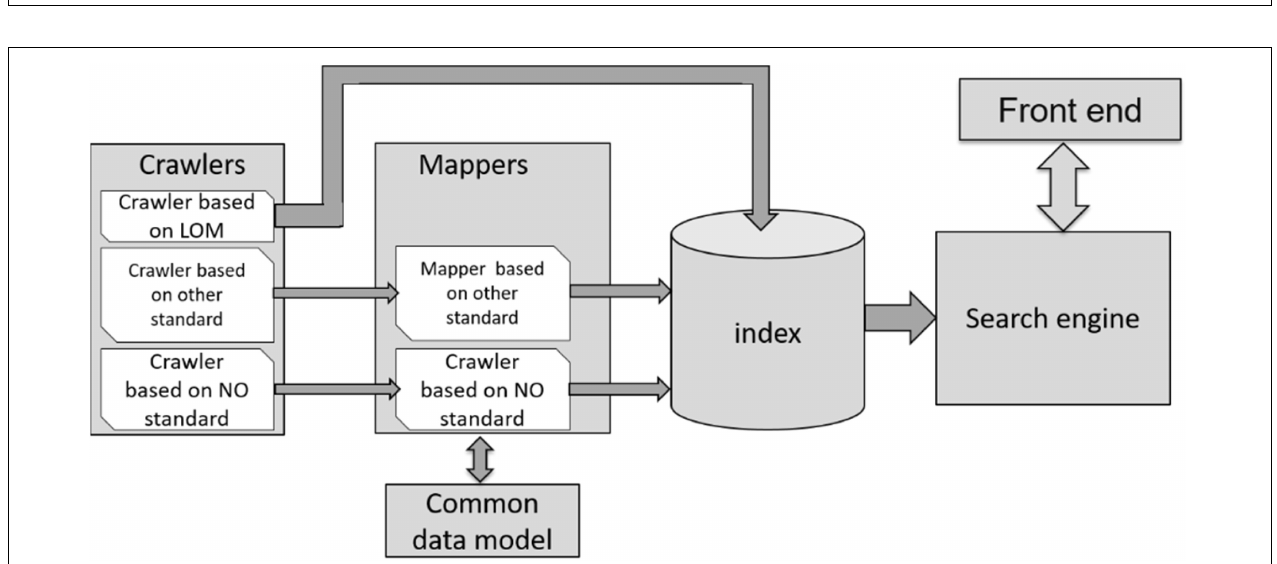
FIGURE 3 | Illustrative presentation of a distributed learning ecosystems (DLE).